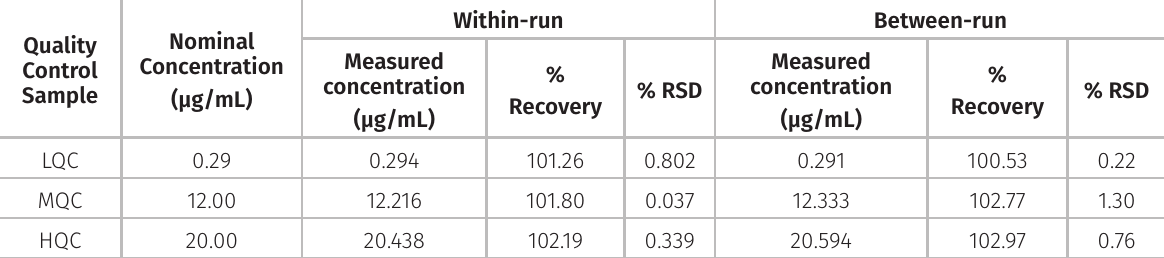
Figure 1. Representative chromatogram of COL using the developed HPLC-PDA method. Table III. Accuracy and precision of the optimized chromatographic